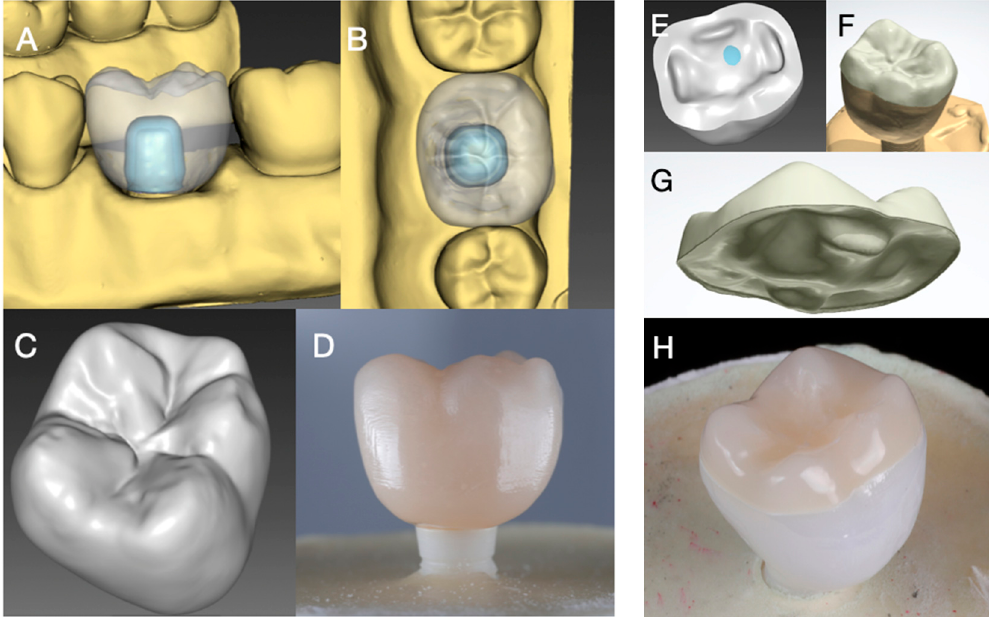
Figure 2. Digital restoration design: ( A – C ) master design for monolithic groups and ( D ) monolithic specimen; ( E – G ) split design of crown into 3Y-TZP ( E ) framework and PICN table top ( G ) of Group RL ( F , H ).